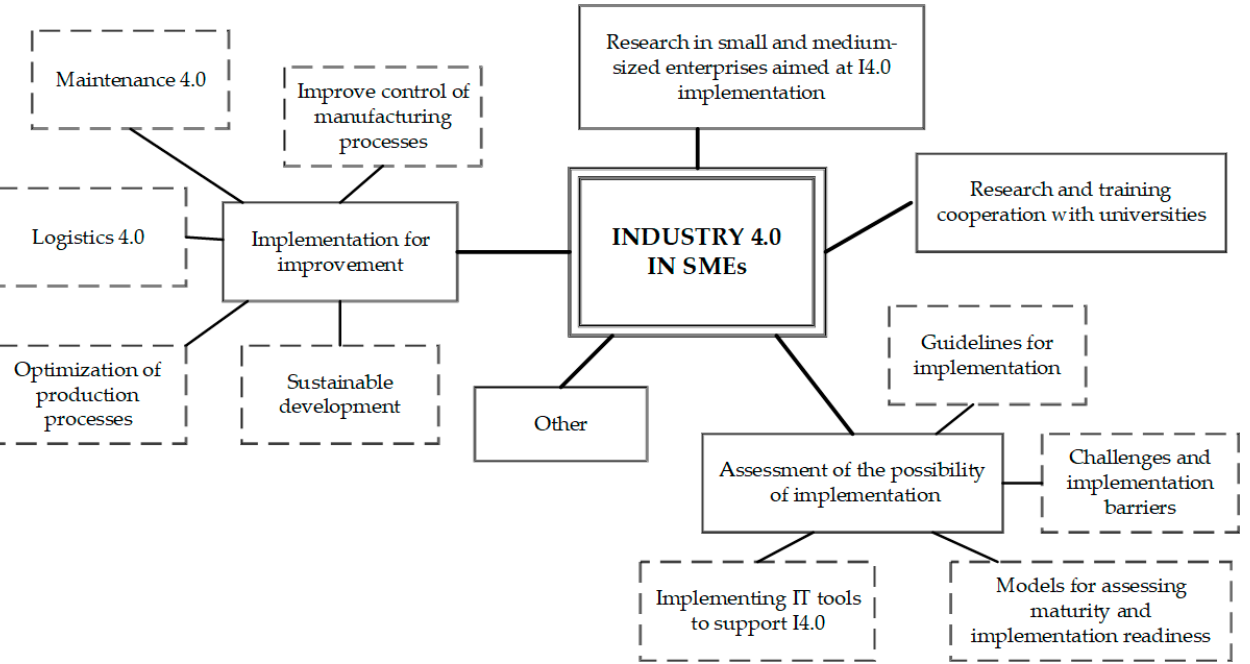
Figure 11. Classification of the scientific publications related to Industry 4.0 in the SME sector. Source: own study.